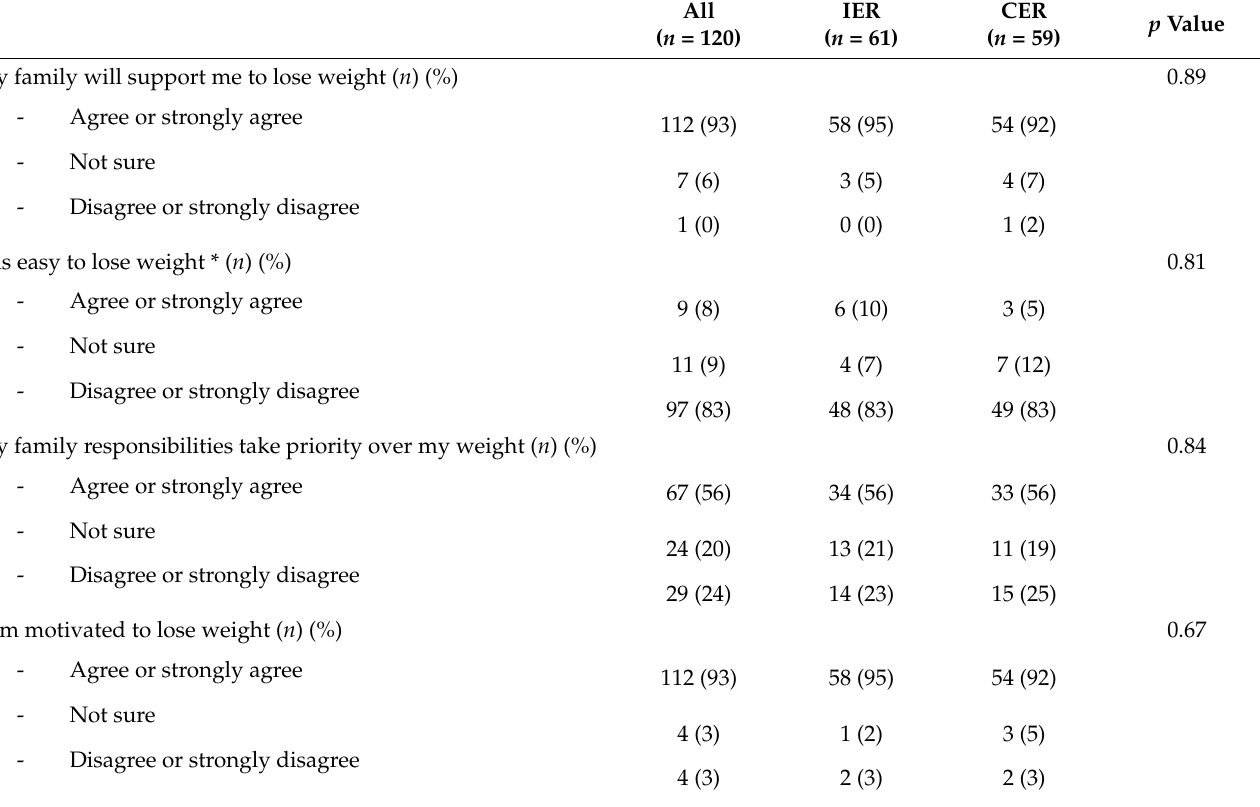
Table 1. Barriers to weight-loss and the perception of future diabetes risk at baseline in a randomized control trial investigating IER in women with previous GDM 1